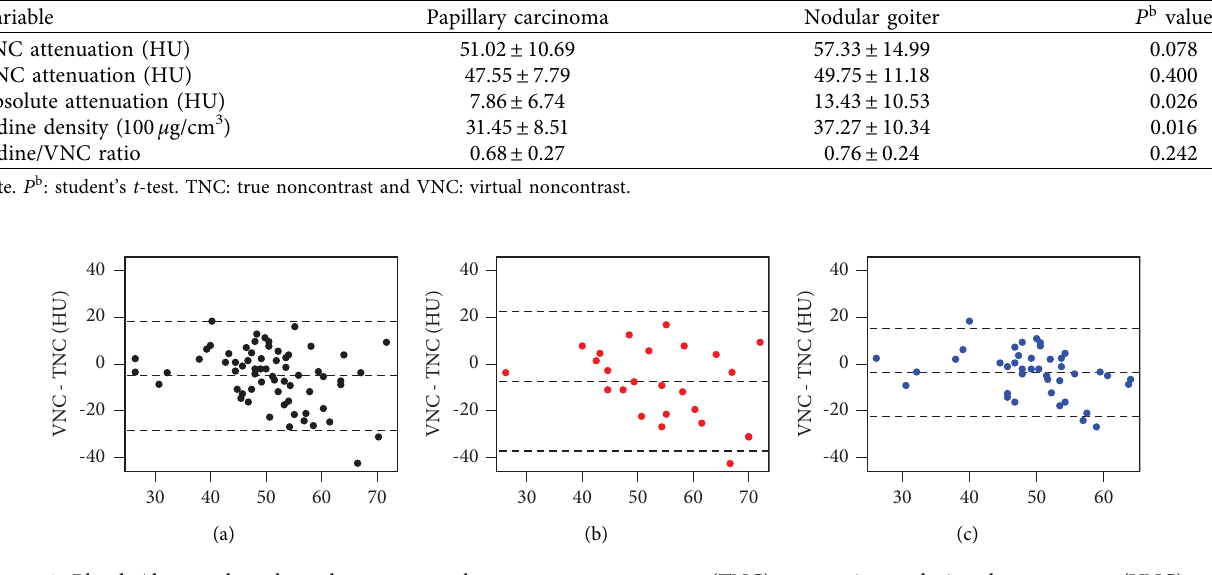
Figure 3: Bland–Altman plots show the agreement between true noncontrast (TNC) attenuation and virtual noncontrast (VNC) at- tenuation in all lesions (a), nodular goiter (b), and papillary carcinoma (c).